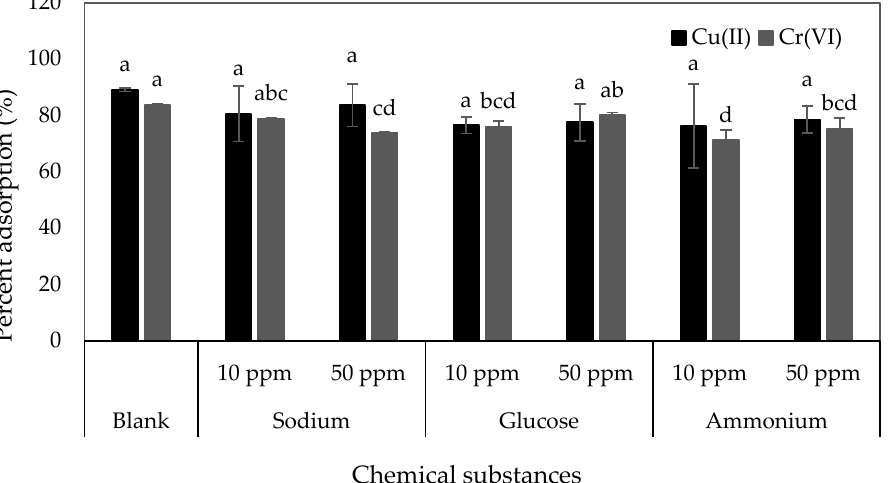
Figure 8. Effect of chemical substances on Cu(II) and Cr(VI) adsorption. [Blank: no presence of chemical substances, C-ZLCH: 0.01 g, volume: 50 mL, metal ions concentration: 25 mg/L, pH: 8.1 for Cu(II) at 60 min, pH: 6.7 for Cr(VI) at 90 min, temperature: 30 °C].